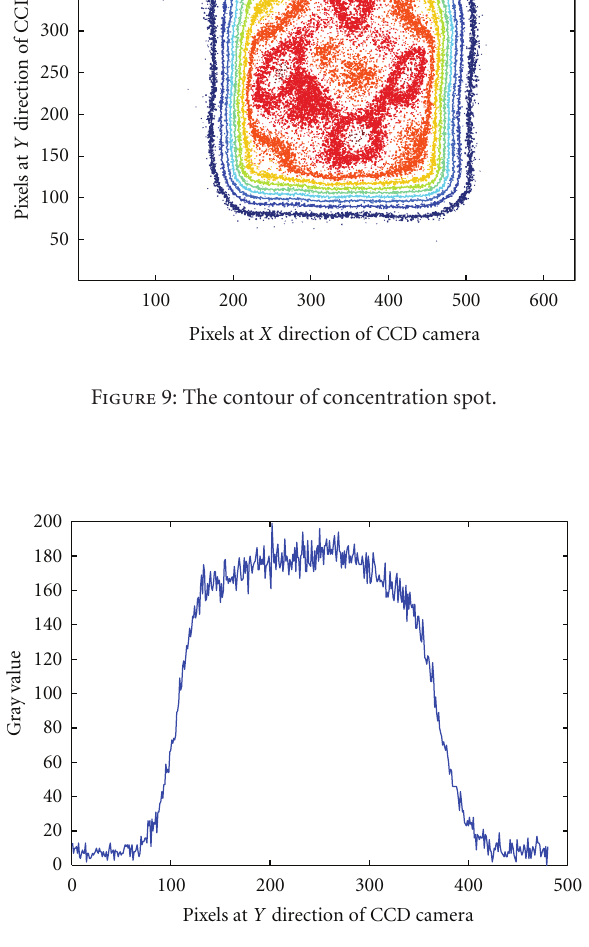
Figure 10: Horizontal illumination distribution of concentration spot on the